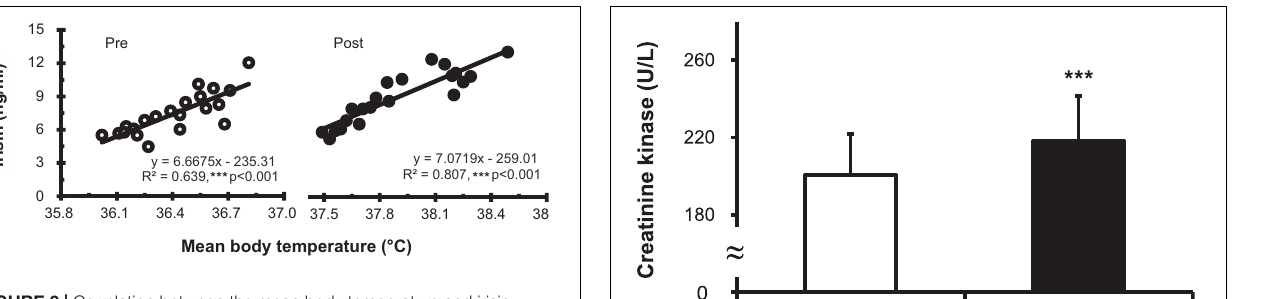
FIGURE 3 | Correlation between the mean body temperature and irisin concentration before (Pre; ◦ ) and after (Post; • ) hot water bath (42 ± 0.5 ◦ C) immersion. *** P < 0.001, statistically significant difference (Pre; R 2 = 0.639, Post; R 2 = 0.807).